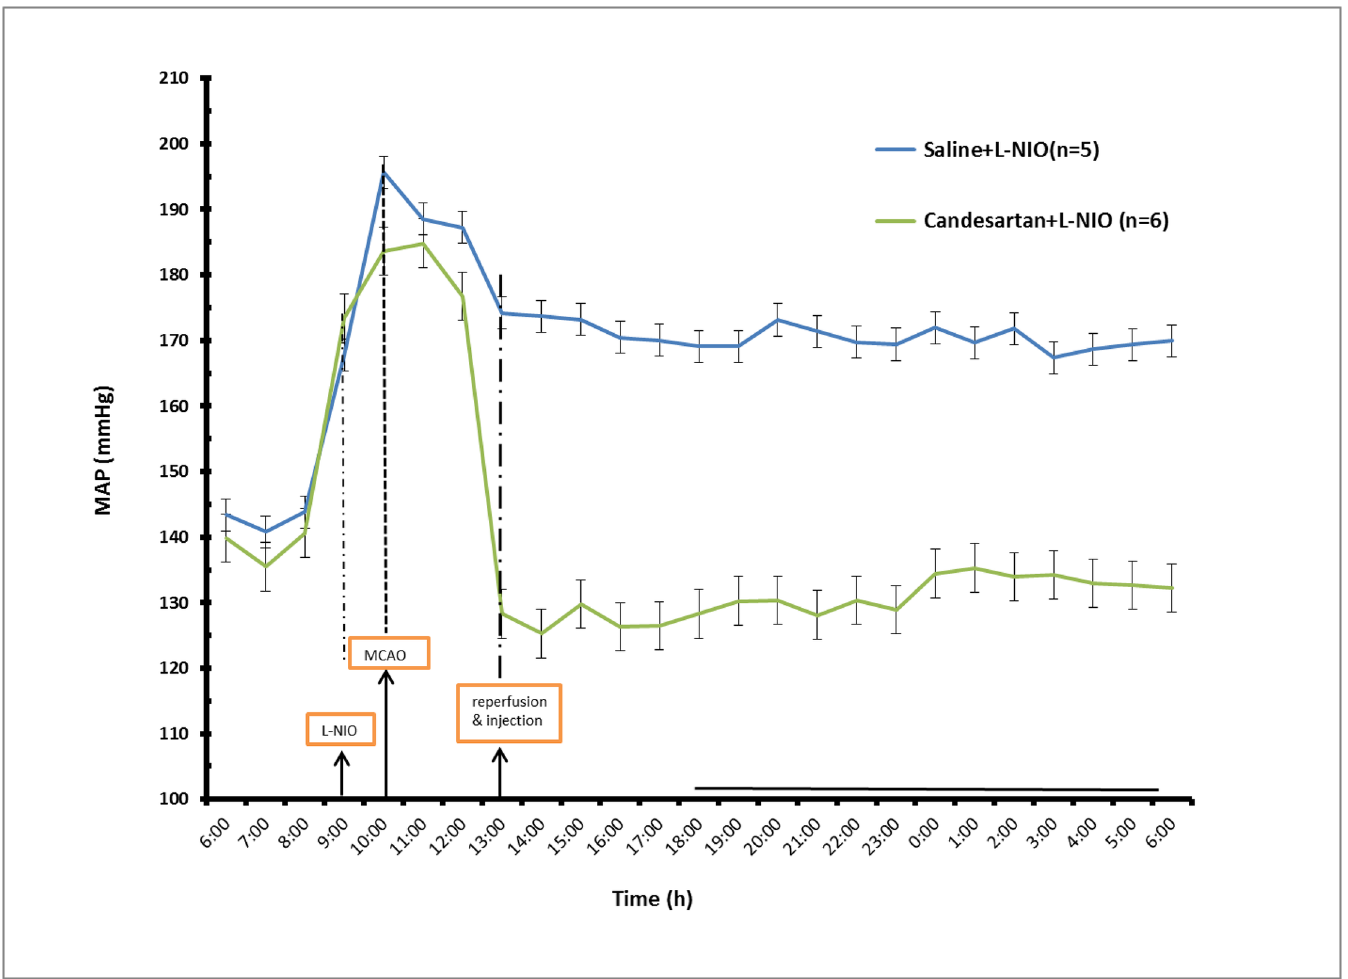
Fig 1. Acute eNOS inhibition did not alter early AT1 blocker treatment induced reduction of blood pressure after the induction of cerebral ischemia. A schematic diagramshowingthe experimental design (A). Blood pressure telemetry showingthe hypotensive effect of Candesartan following cerebralischemia. This effect was not altered with acute eNOS inhibitionbefore the inductionof cerebralischemia. Data presented as mean ± SEM; n = 5–6 animals per group.